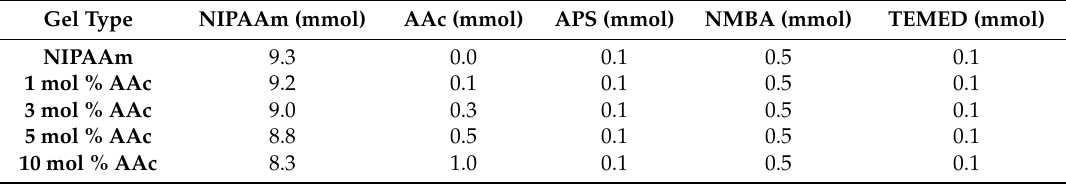
Table 1. Feed composition of Poly (NIPAAm/AAc) composite hydrogels.